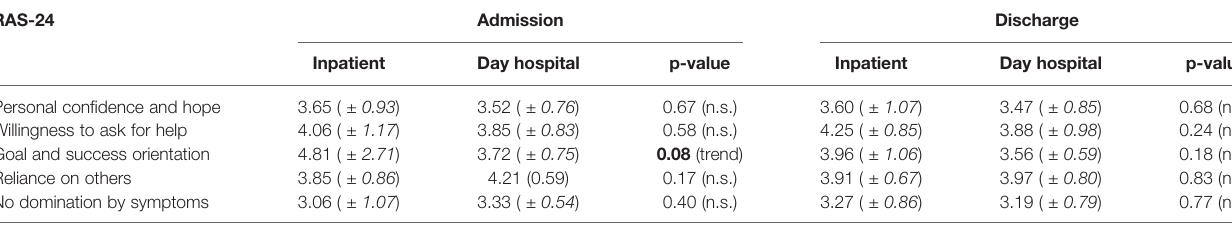
TABLE 6 | Recovery Assessment Scale (RAS-24), mean scores (± standard deviation , p-values (t-tests, inpatient versus day hospital). RAS-24